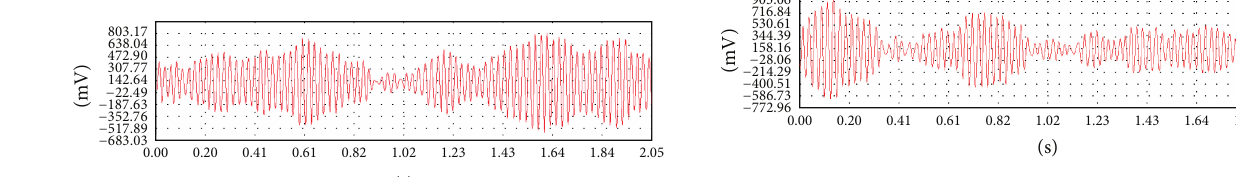
Figure 20: Voltage of the control current when the mean wind velocity 𝑉 =